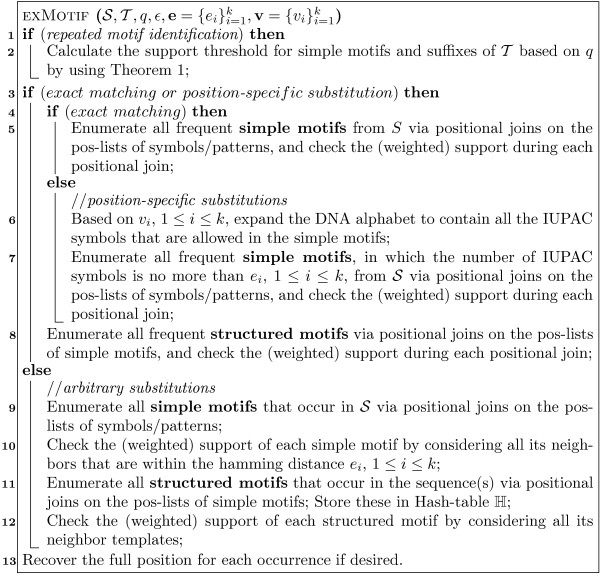
EXMOTIF Algorithm.